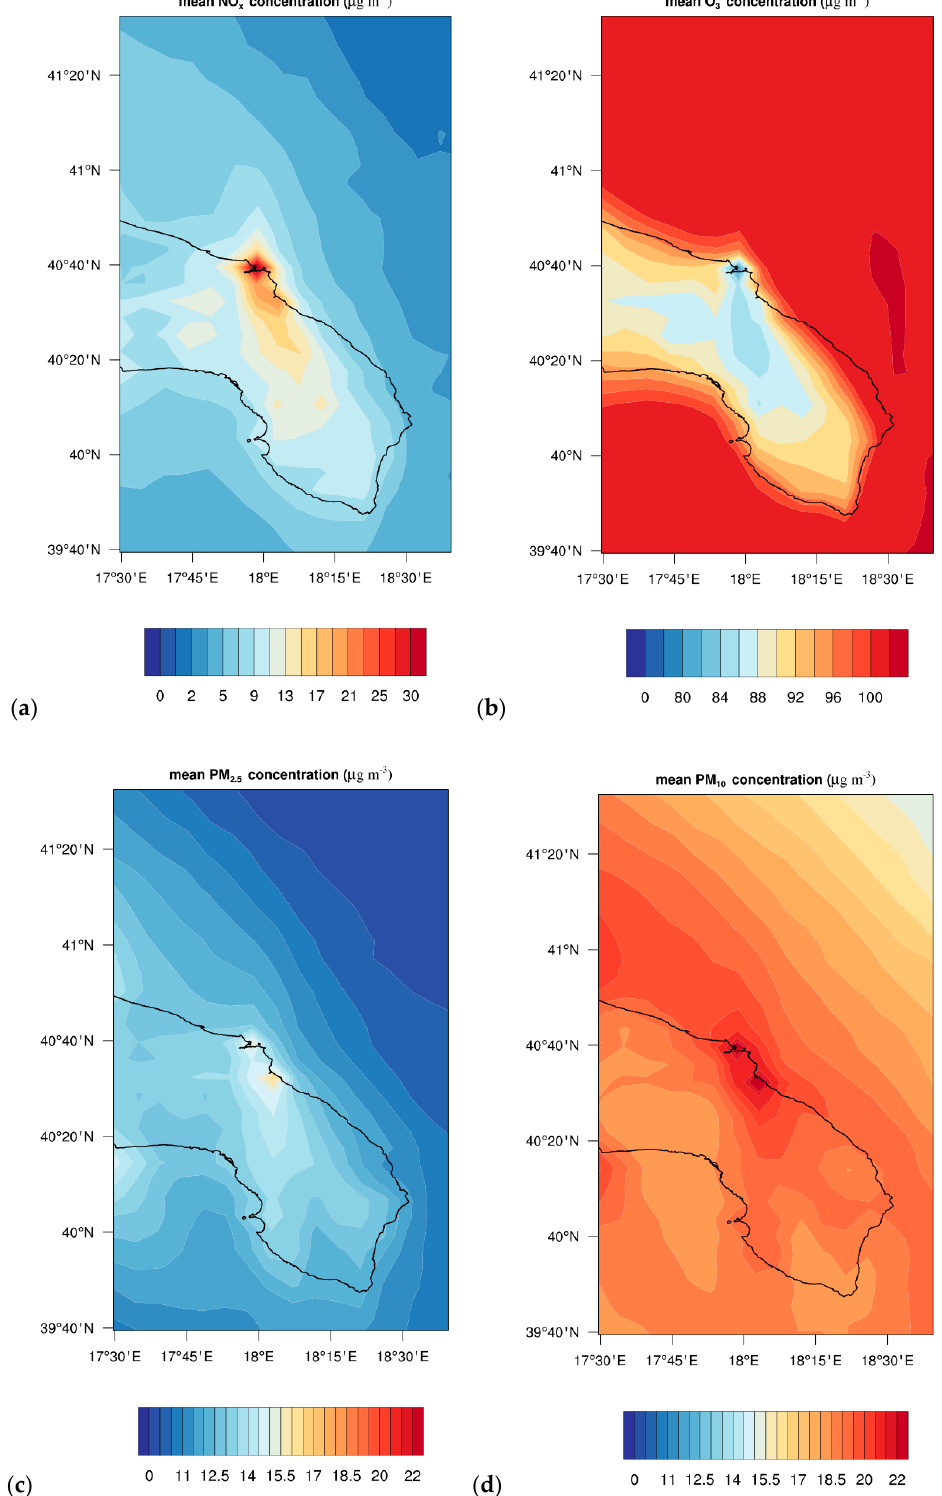
Figure 4. Average surface concentrations ( μ g m − 3 ) of ( a ) NO X , ( b ) O 3 , ( c ) PM 2.5 , and ( d ) PM 10 obtained from BOLCHEM for the period June–October 2012 in the area surrounding the port.